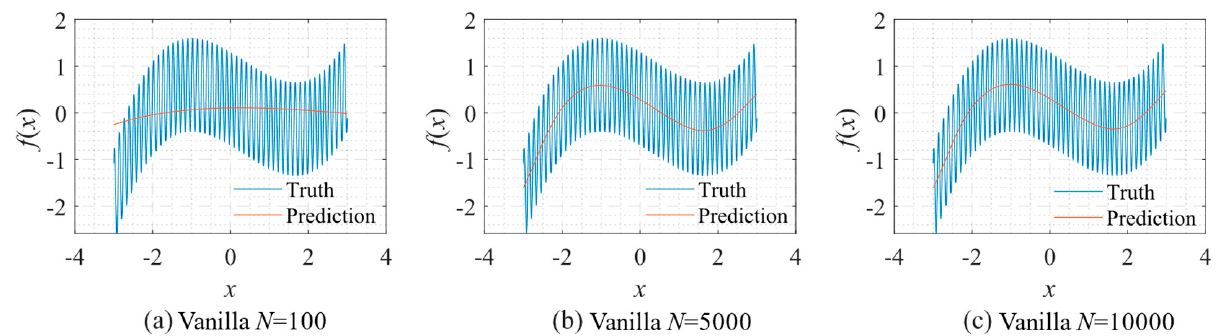
Figure 5. Function fitting using vanilla fitting: ( a ) N = 100; ( b ) N = 5000; and ( c ) N = 10,000.